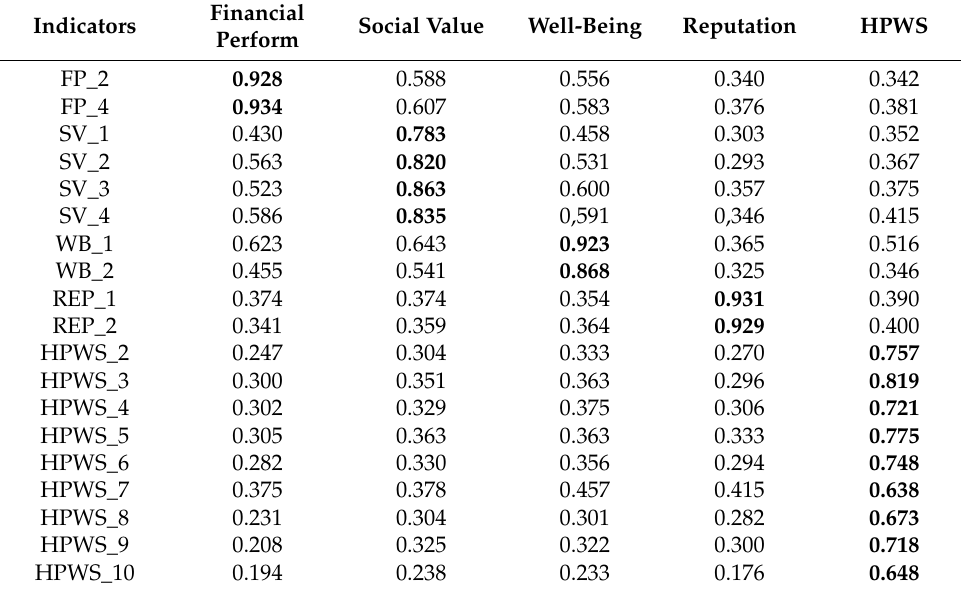
Table 3. Cross Loadings (Source: our own based on SmartPLS).